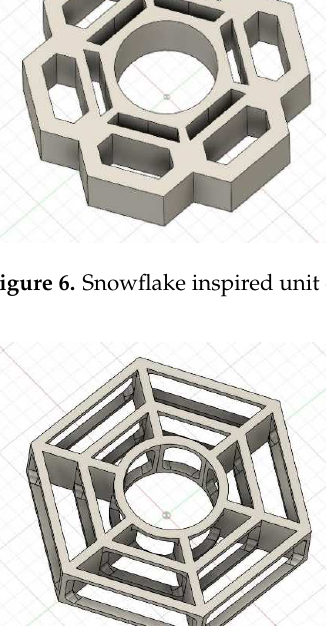
Figure 7. Spider web-inspired unit cell (8 × 8 × 2 mm 3 ).